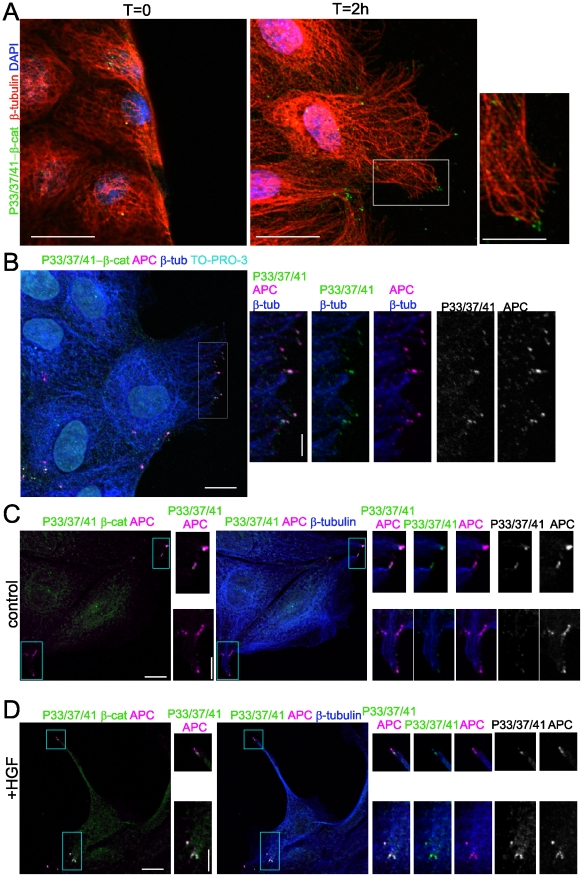
Phospho-β-catenin and APC are localised to the ends of microtubules in migrating cells.(A) P33/37/41-β-catenin in clusters at the wound edge. Representative images of cells fixed at T = 0 (left) and 2 hours after wounding. P33/37/41-β-catenin (green), β-tubulin (red), DAPI (blue). Scale 20 µm; inset 10 µm. (B) P33/37/41-β-catenin and APC in migrating MDCK cells. Merged image shows coincident (white) P33/37/41-β-catenin (green) and APC (magenta) at the ends of microtubules (β-tubulin, blue). Nuclei were visualised with TO-PRO-3 iodide staining (cyan). Scale 10 µm. Insets show enlarged view of the leading edge of migrating cells. Scale bar 5 µm. (C and D) MDCK cells were serum starved and untreated (C) or stimulated with 2 ng/ml HGF for 6 h (D) and immunostained with antibodies to P33/37/41-β-catenin (green), APC (magenta) and β-tubulin (blue). Scale 10 µm. Insets show clusters at microtubule ends that are highly concentrated in HGF treated cells. Scale bar 5 µm.